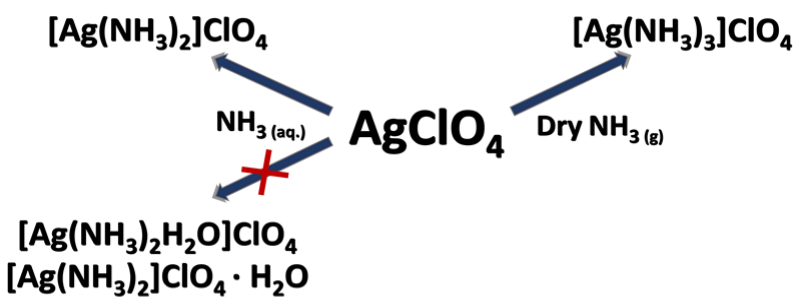
Figure 2. Schematic representation of phases formed in the AgClO 4 -NH 3 and AgClO 4 -NH 3 -H 2 O systems.